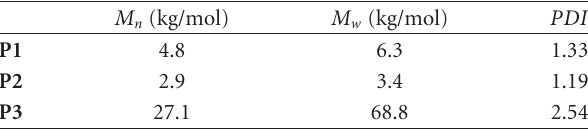
Figure 2: UV-Vis spectra of P1 (black), P2 (blue), and P3 (red) in chloroform solution (solid) and film (dashed). Spectra are normal- ized by area. Table 1: Molecular weight of the